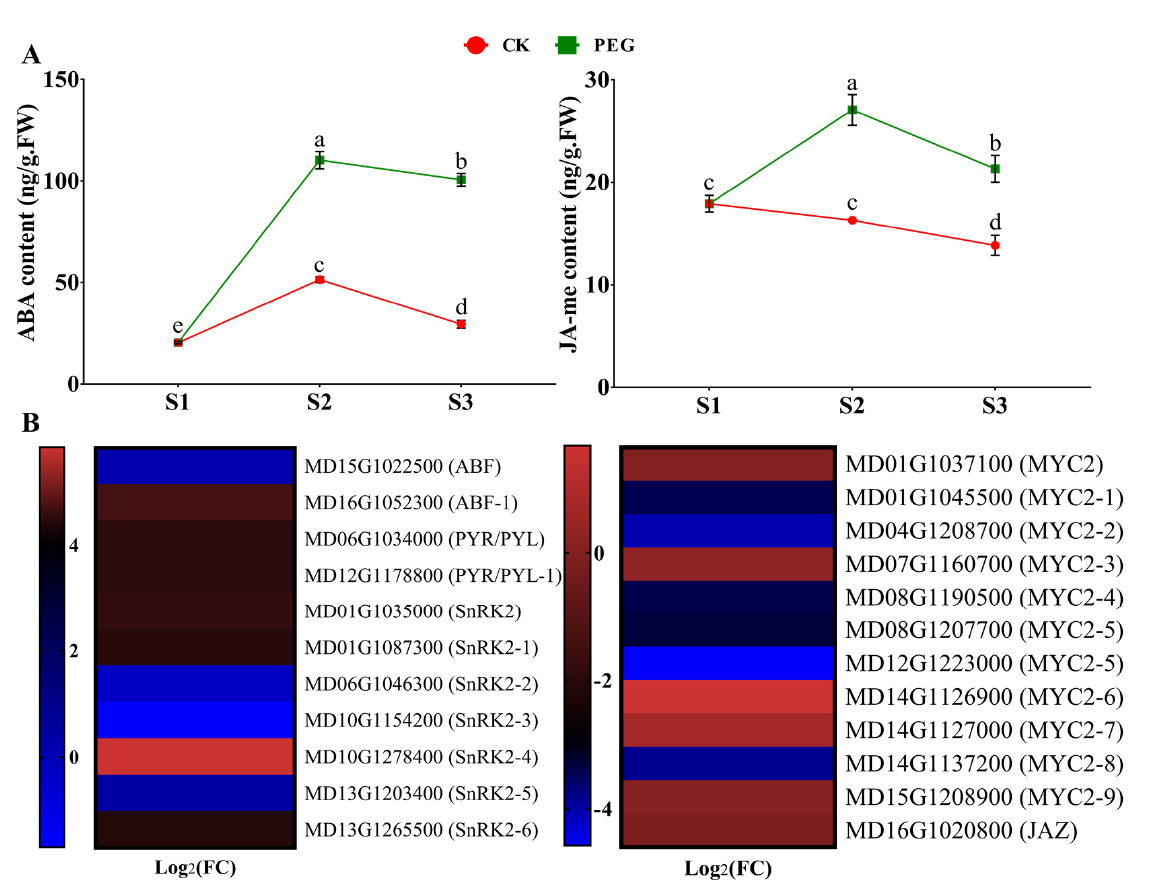
Figure 5. Effect of a polyethylene glycol (PEG) treatment on the endogenous content of abscisic acid (ABA) and methyl jasmonate (JA-me) over the course of this study (S1, S2, and S3) during adventitious root (AR) formation in GL-3 apple cuttings when compared to a PEG-free control (CK) group. Error bars refer to the average value ± SD from three biological replicates. Different letters indicate significant differences by least significant difference (LSD) test at p ≤ 0.05 ( A ). Selected differentially expressed genes (DEGs) related to ABA and JA from RNA sequencing data (only at S2 of CK and PEG treatment). Heat map diagram of the log2FC, the red and blue colors specify up-and down-regulated expressions ( B